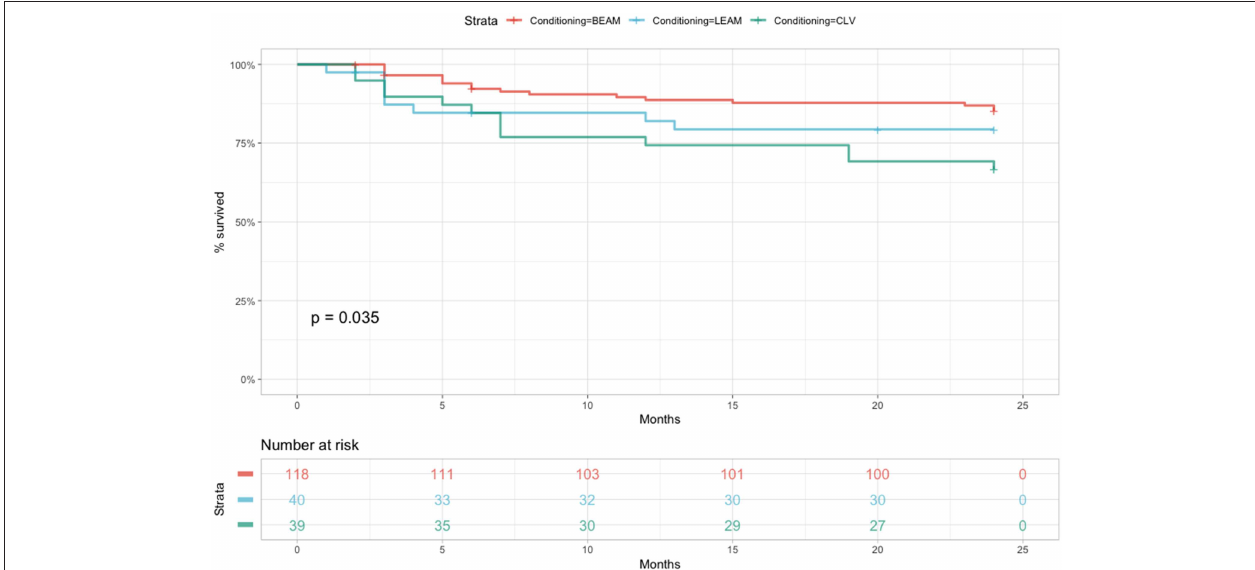
FIGURE 2 | RFS comparing the three conditioning chemotherapy regimens at 2 years.